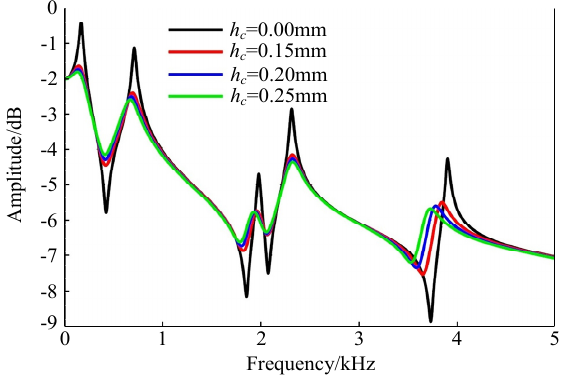
Figure 10. Frequency response functions of the blisk with different coating thicknesses.